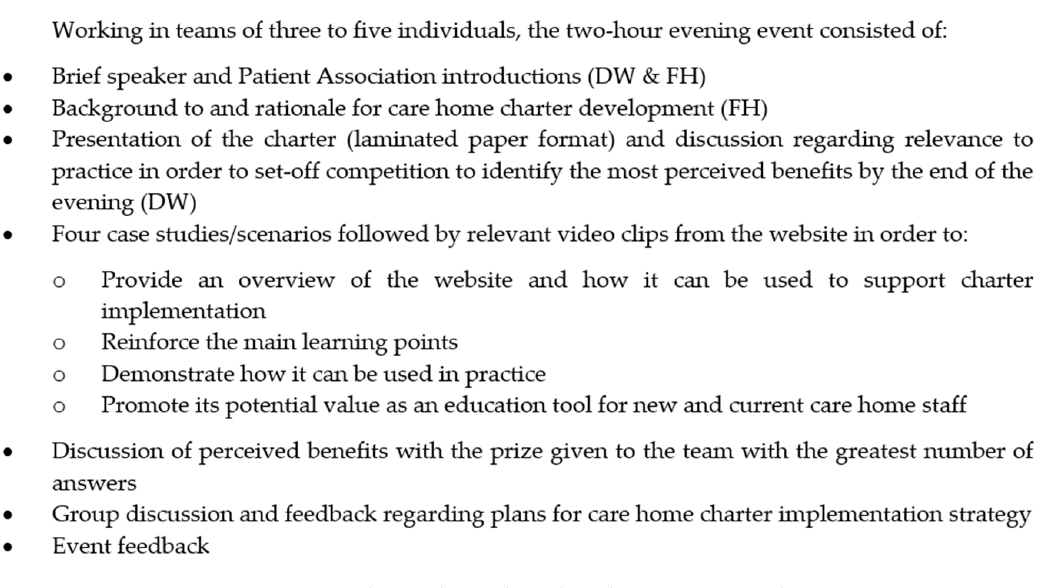
Figure 2. Care home charter launch and training event plan.